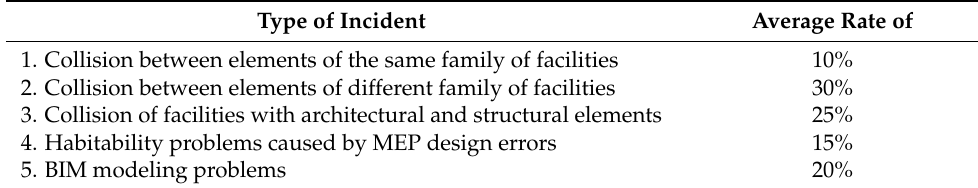
Figure 7. Virtual representation of problems of a lack of height or habitability for MEP design error. Problems of coordination between architectural elements and plumbing pipeline ( above ) and problems of height with plumbing pipeline ( below ). BIM Model.